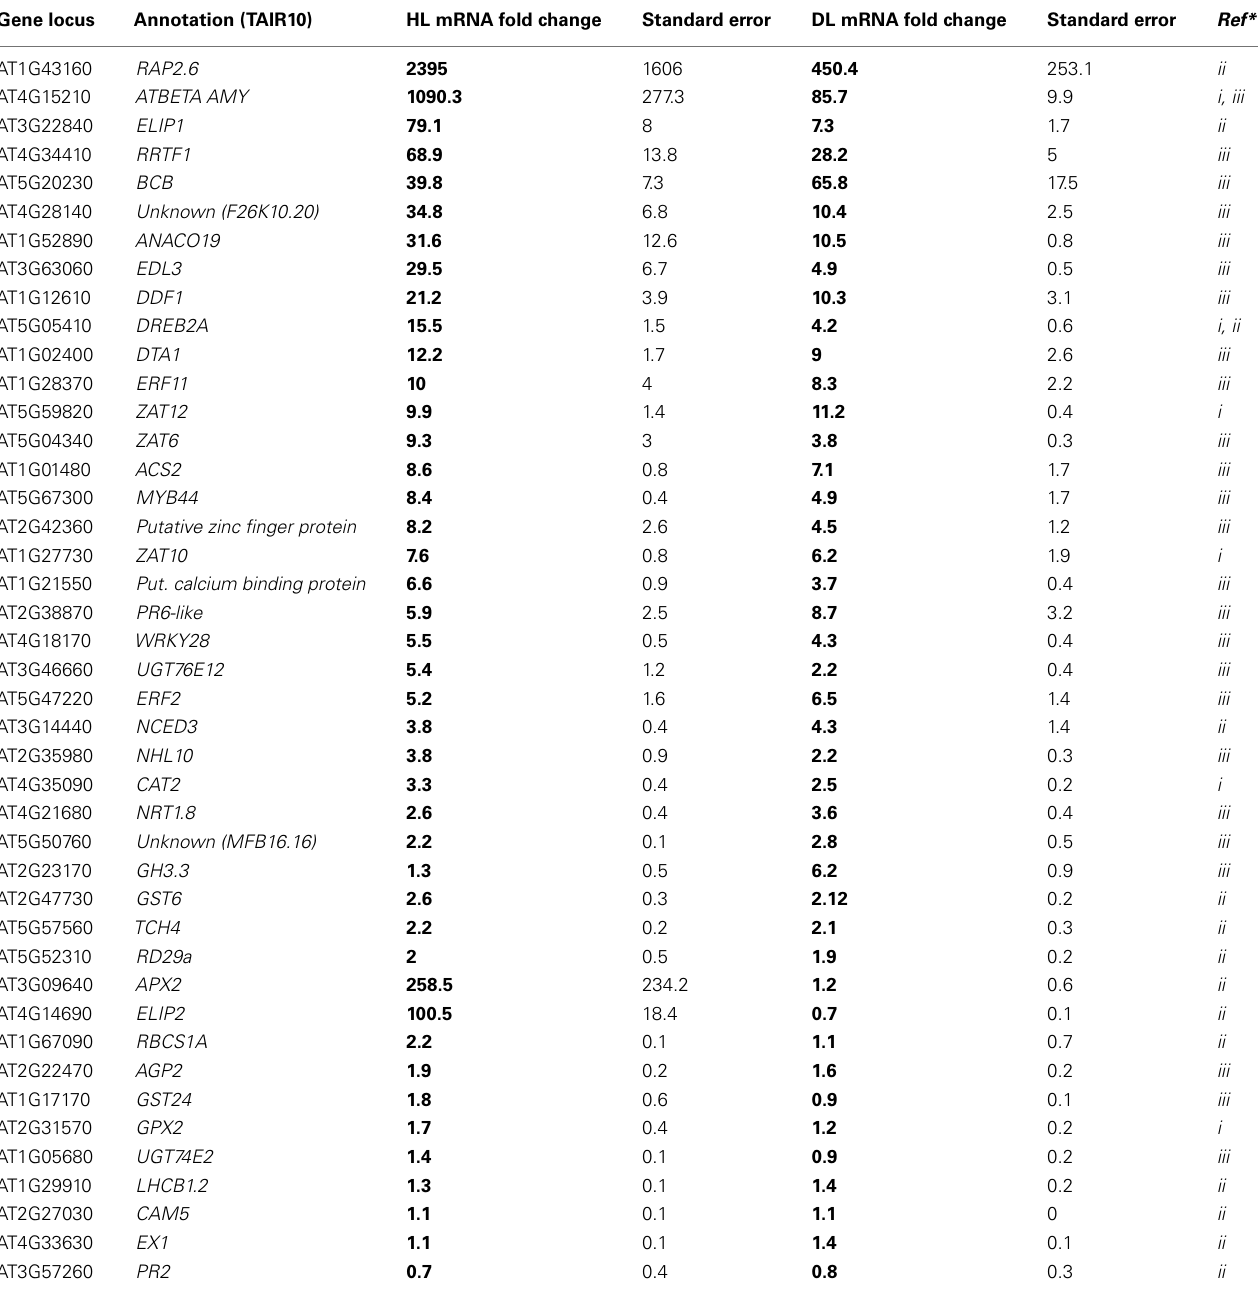
Table 1 |Analysis of gene transcript abundance after 60min HL LED-array